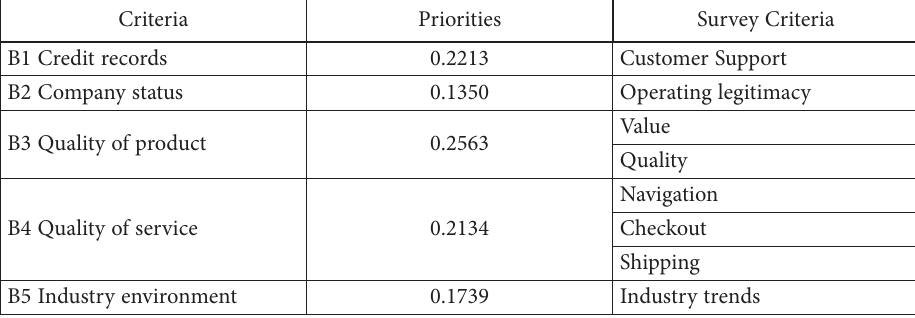
Table 13. Survey and reader scores from Consumer Reports Website Value Qua lity